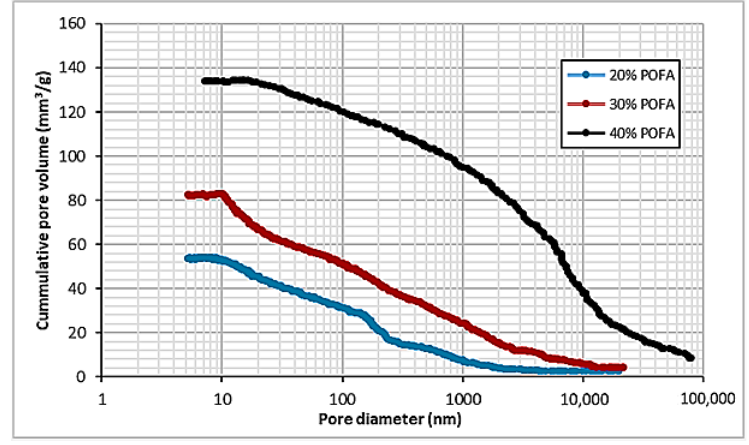
Figure 13. Pore Distribution of ECC containing 20%, 30%, and 40% POFA.